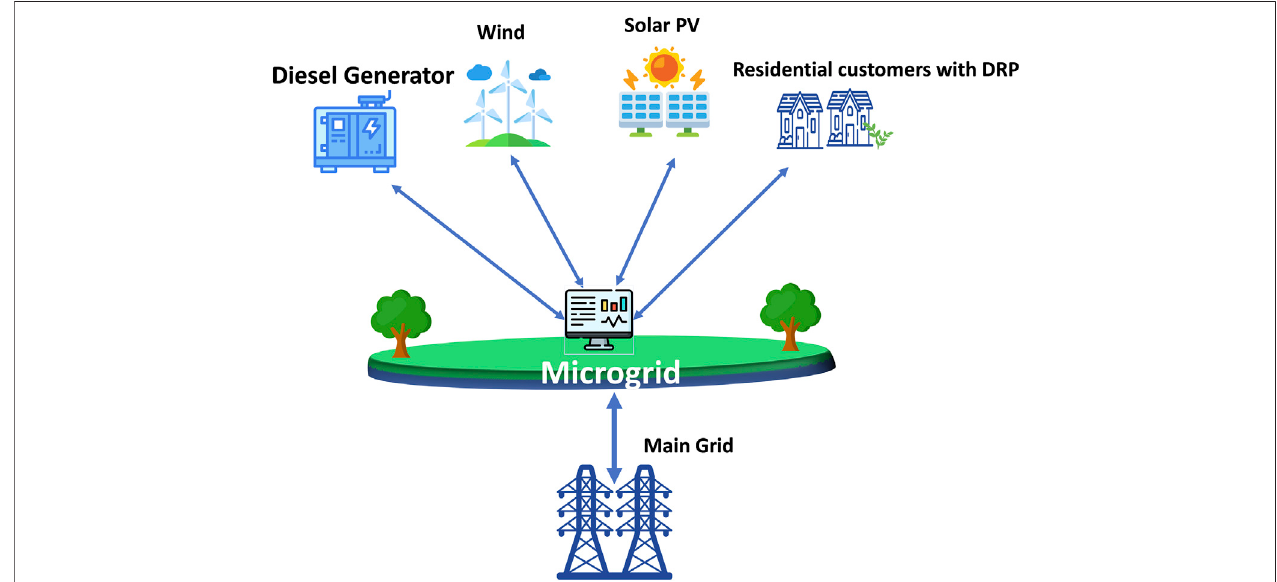
FIGURE 1 | Grid-connected MG structure with DR